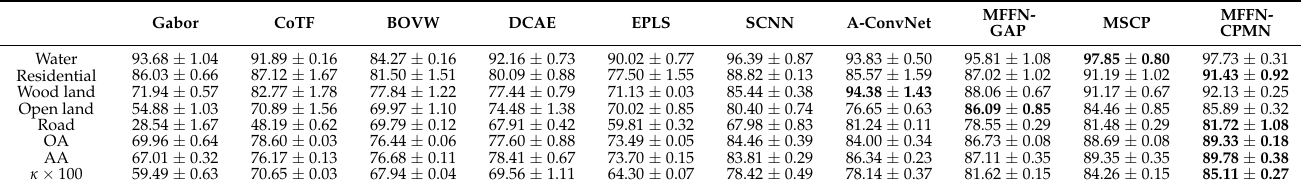
Table 5. Classification performance of TerraSAR-X SAR image with different